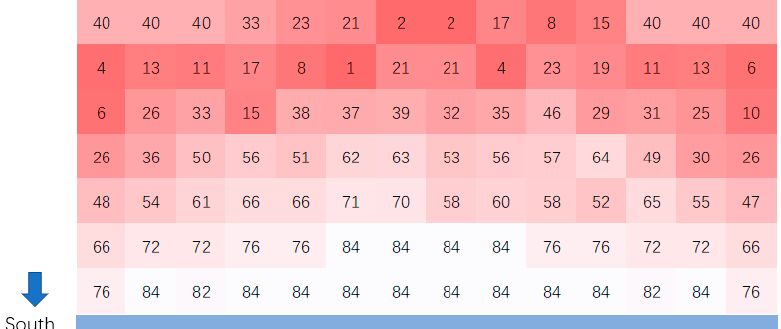
Figure 6. The priority domain distribution of sensor location in the open-plan office space. 4.3. Shading Control Sensor Position on Different Window-to-Wall Ratios To evaluate the small office space example, the sensor positions selected for shading control, the influence of different window-to-wall ratios on the attribute weights distribu- tion, and the Equal Priority Domains are investigated.